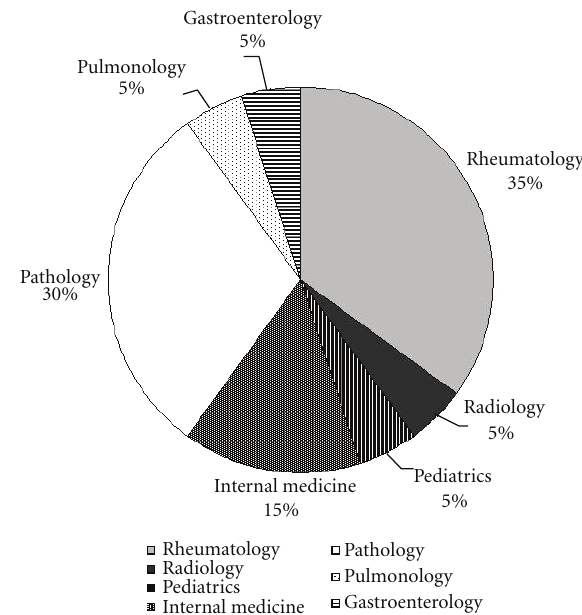
Figure 2: Subspecialties of IgG4-RD RI Simulation Exercise Partici- pants ( n = 21) there were 21 participants completing the simulation exercises and the pie chart represents the percentage breakdown for each medical subspecialty.